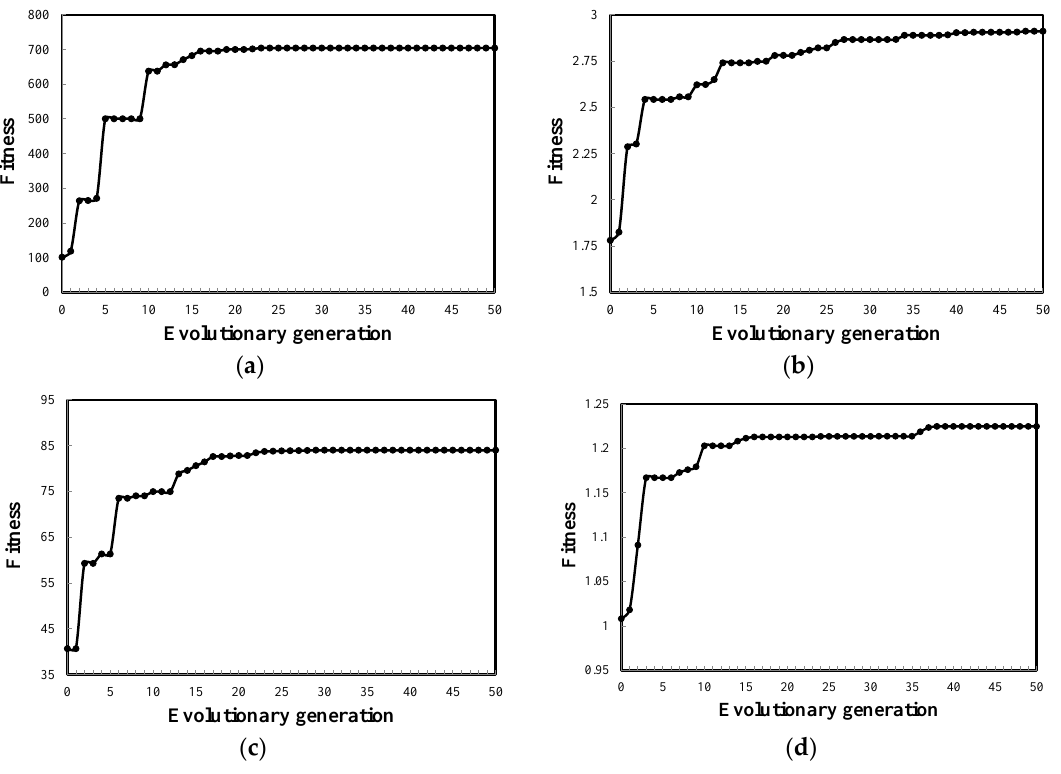
Figure 11. Optimization of the PQE employed in the four control loops of the TC-PQE scheme (Example II): ( a ) top control loop; ( b ) upper sidestream control loop; ( c ) lower sidestream control loop; ( d ) prefractionator control loop.